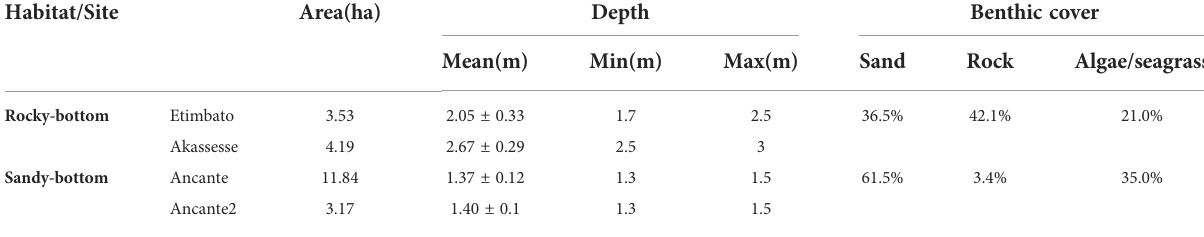
TABLE 1 Characteristics of two green turtle foraging habitat types surveyed at Unhocomo and Unhocomozinho islands, Guinea-Bissau. Habitat/Site